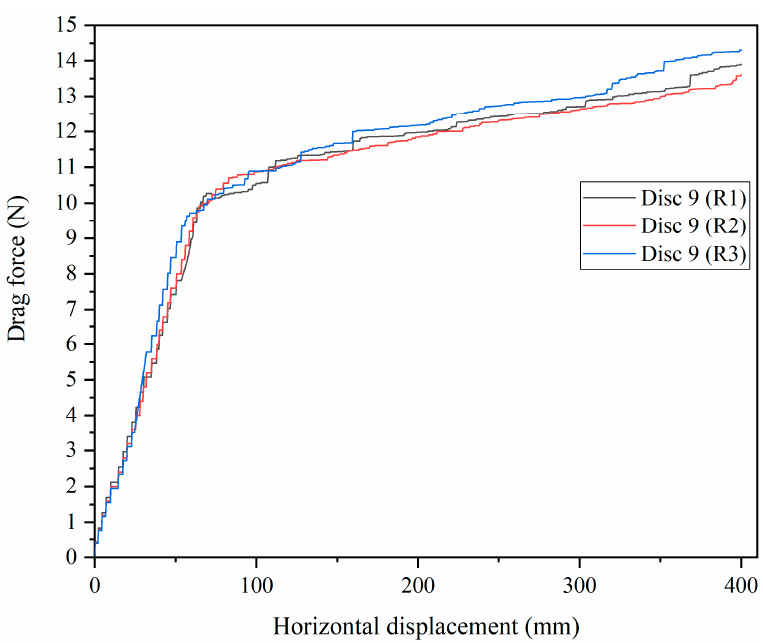
Figure 6. Repeatability of tests (Disc 9, silty loam soil “S1” with a moisture content of 30%).